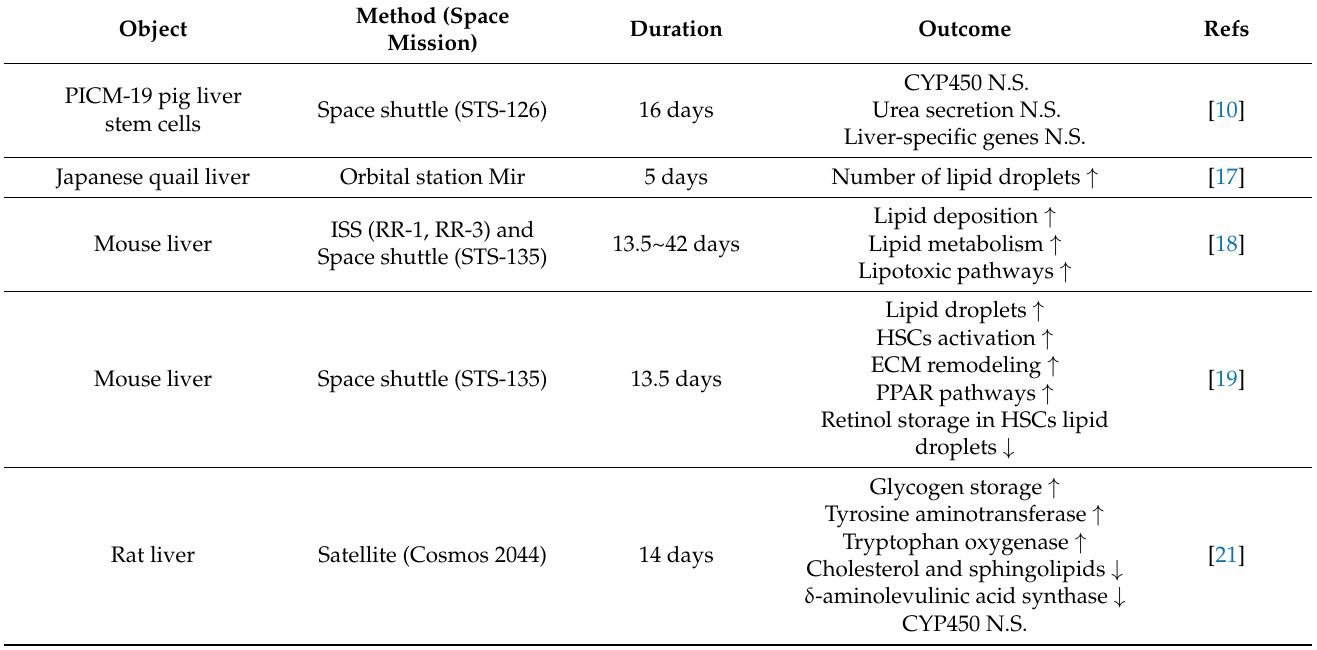
Table 1. Effects of spaceflight on liver